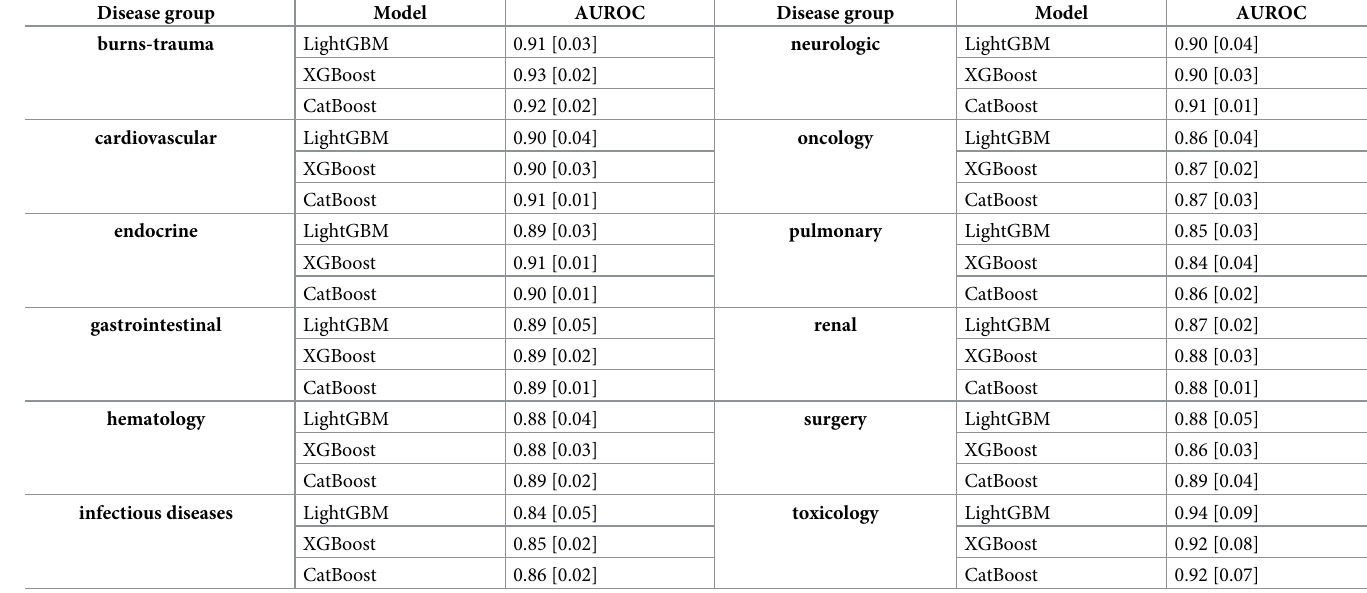
Using the GBT models described in the methodology section, we evaluated the perfor- mance of XGBoost, LightGBM, and CatBoost via AUROC scores. The results are summarized in Table 3. The three introduced GBT models differ in main characteristics, including the splitting technique, leaf growth, and categorical feature handling. For splitting, XGBoost does not use any weighted sampling techniques; on the other hand, LightGBM uses GOSS that performs splitting using all the points with huge gradients and a random sample of points with small gradients. GOSS reduces the number of instances and balances accuracy and speed. CatBoost implements a novel splitting technique called Minimal Variance Sampling (MVS). This sam- pling mechanism occurs at the tree level, maximizing split scoring accuracy. XGBoost Table 3. Cross-validation results (mean AUROC [standard deviation AUROC]) of GBT models using 10-fold cross-validation. Disease group Model